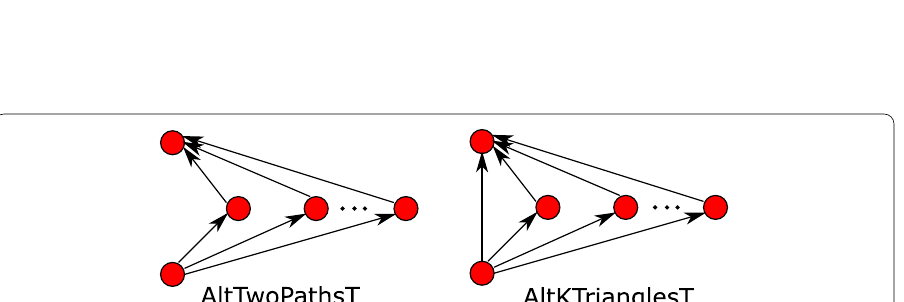
Fig. 4 Alternating two-paths and alternating transitive triangles ERGM configurations for directed networks. Unlike motifs, ERGM configurations are not induced subgraphs, so it is normal (and often required) for one to be a subgraph of another. So AltTwoPathsT and AltKTrianglesT are frequently included in a model together, with AltKTrianglesT consisting of the AltTwoPathsT configuration “closed” by the addition of an